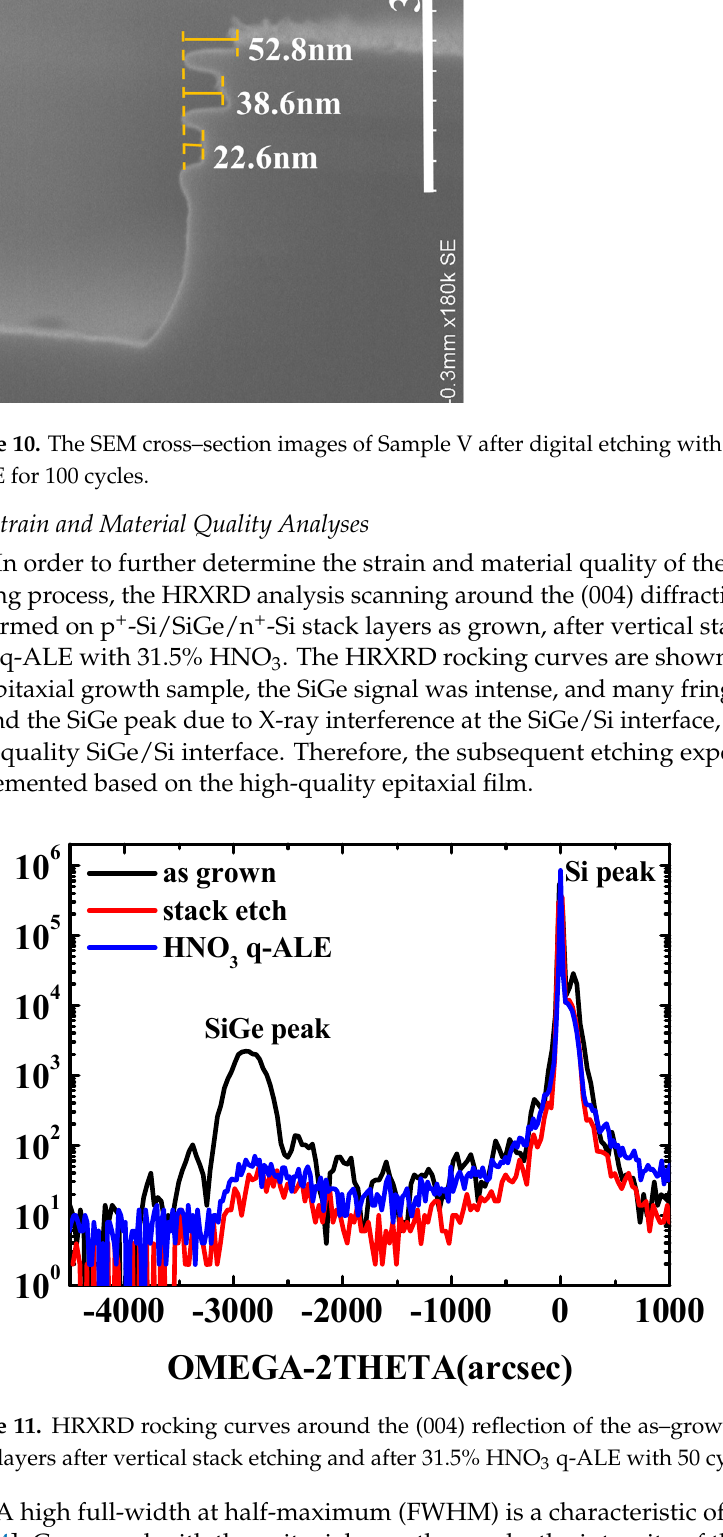
3 -dBOE q-ALE for 100 cycles. As shown in Figure 10, there is a selectivity for n + -Si in